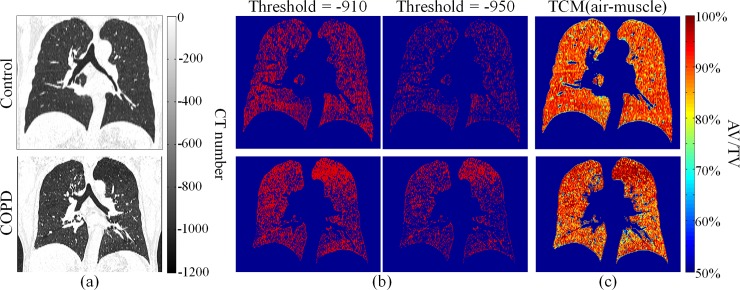
(a) Chest CT images of a control participant (top) and a patient with (bottom). (b) Binary segmentation results (a) using thresholds of 910 and 950. (c) AV/TV maps calculated (a) using the TCM with an air–muscle submaterial pair.